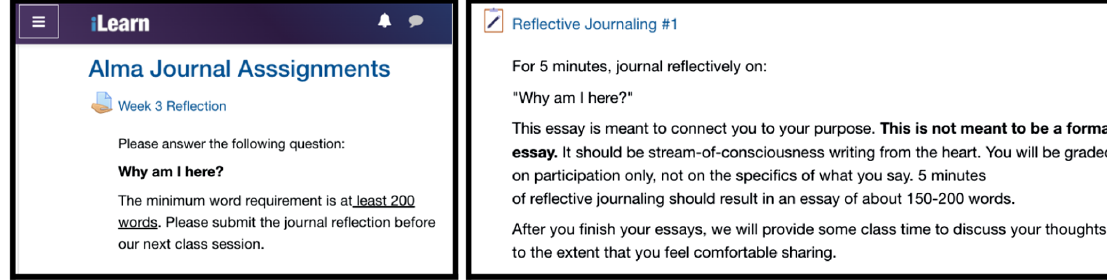
FIG. 2. Screenshots of initial (left) and final (right) versions of instructions in the